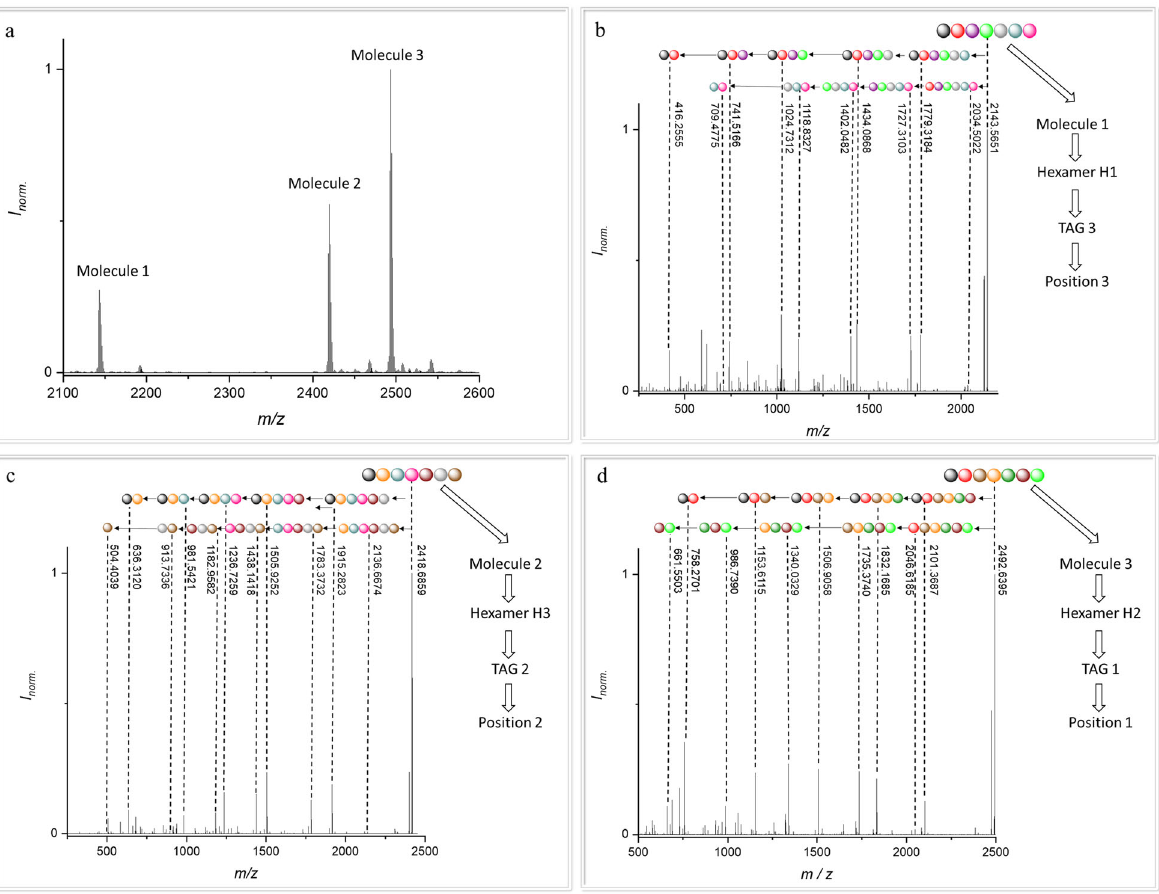
Fig. 6 Read-out of a mixture of three hexamers, with clearly de fi ned positions of the TAGs to increase the data storage capacity. a ESI-MS spectrum of a mixture of three different hexamers H1-H3 that was used for subsequent tandem ESI-MS/MS fragmentation. For the fragmentation, one of the respective molecule peaks was chosen at a time. b fragmentation of hexamer H1. c fragmentation of hexamer H2. d fragmentation of hexamer